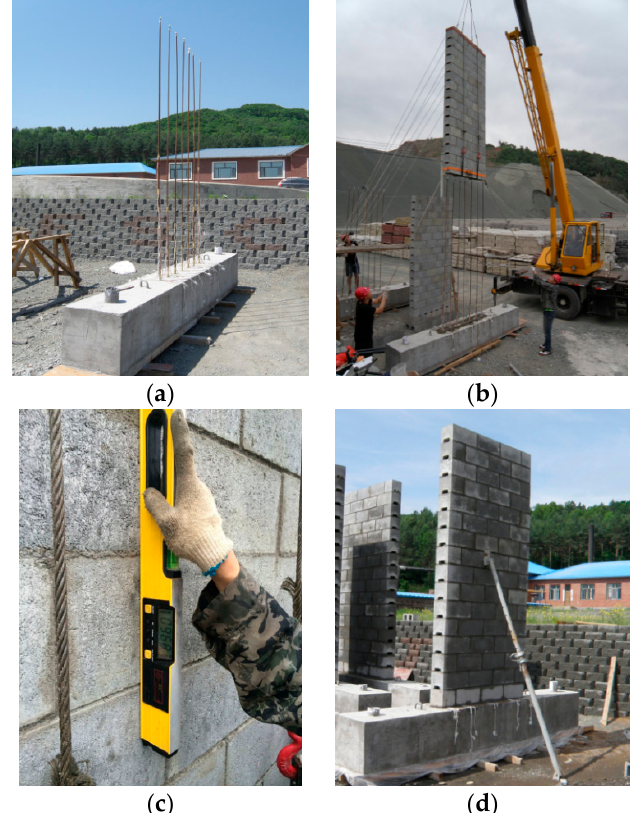
Figure 3. Construction procedures for the prefabricated reinforced masonry shear wall (PRMSW): ( a ) Construction of the foundation beam and the vertical rebar; ( b ) lifting and assembling the prefabricated wall; ( c ) checking the perpendicularity of the PRMSW; and ( d ) the fixing of the PRMSW using a stretchable anchor